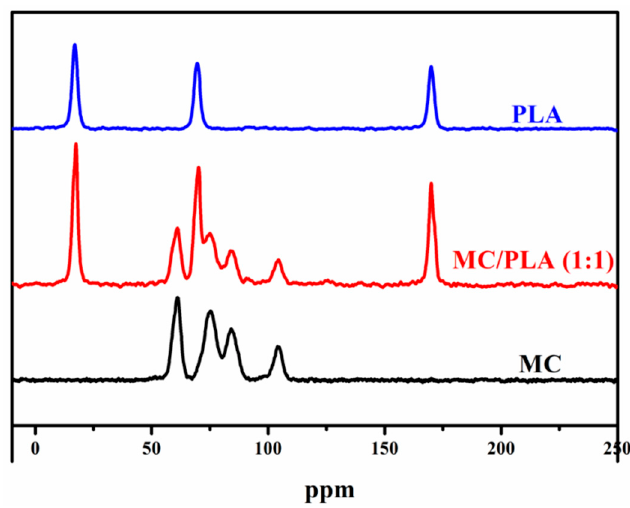
Figure 4. Solid-state 13 C NMR spectra of PLA, MC / PLA (1:1) membrane, and MC.